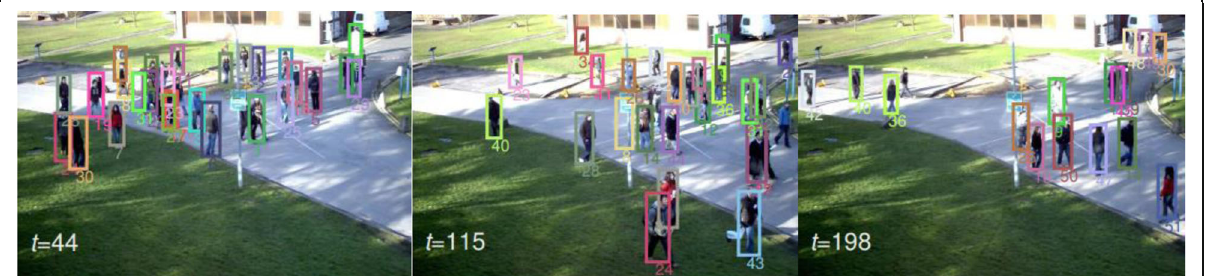
Fig. 8 Illustration of tracking multiple human targets in a crowded scene